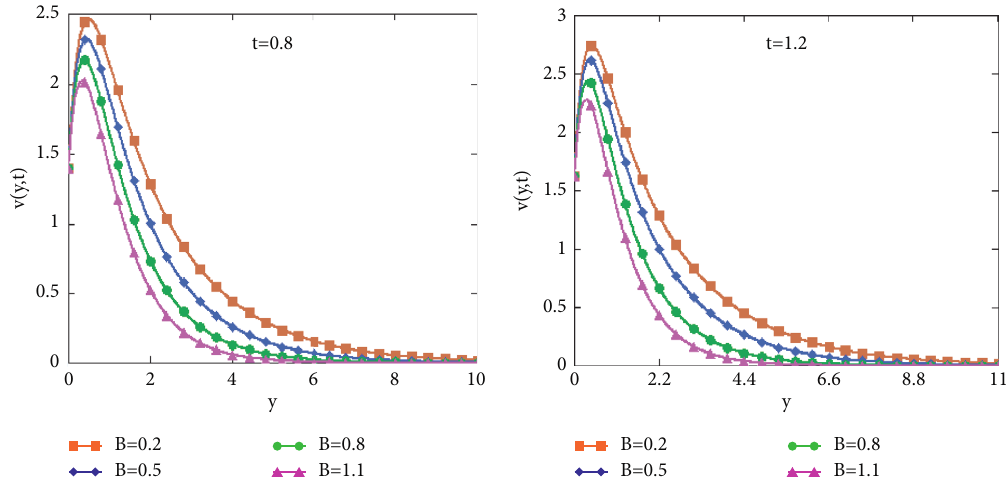
Figure 1: Velocity diagram v ( y, t ) for various values of Brinkman parameter B at R � 1 . 4 ,Q � 0 . 4 , Gr � 9 , Gm � 6 , M � . 85 , α � β � c � 0 . 5 , Sc � 4 . 5 , andPr � 4 . 0.